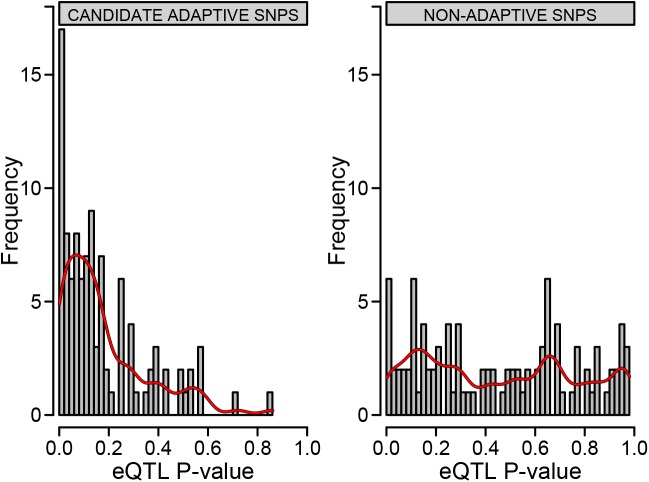
Comparing positive selection with gene regulation.Summary distribution of permuted eQTL p values for SNPs with (left) or without (right) a significant selection signal. SNPs with a significant selection signal (iHS) were chosen by taking the largest significant positive selection signal (if one was present) within each gene-population combination. The same number of SNPs without a significant selection signal were also randomly drawn across all gene-population combinations for comparison. These SNPs were used in an eQTL analysis where they were regressed (including gender as a covariate) against their associated gene probe’s expression.